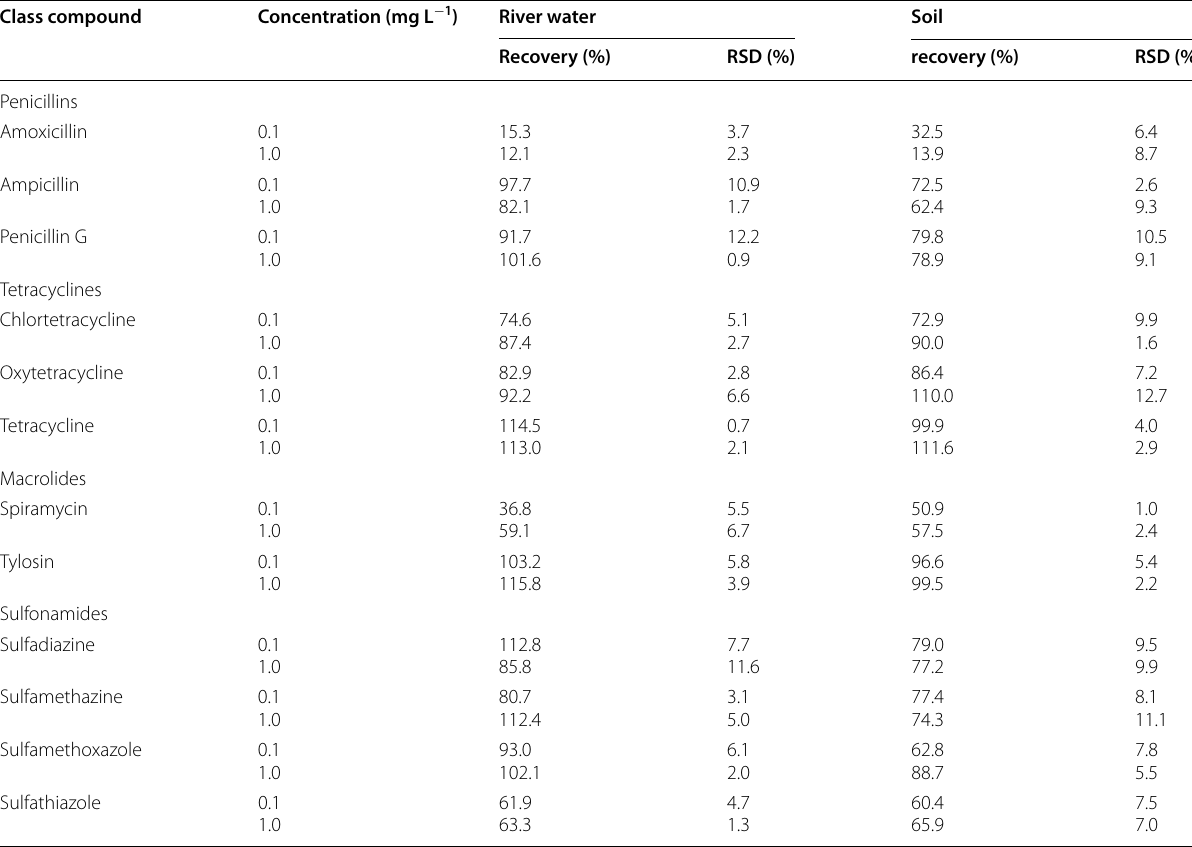
Table 3 Recovery and precision of the developed method for 12 antibiotics Class compound